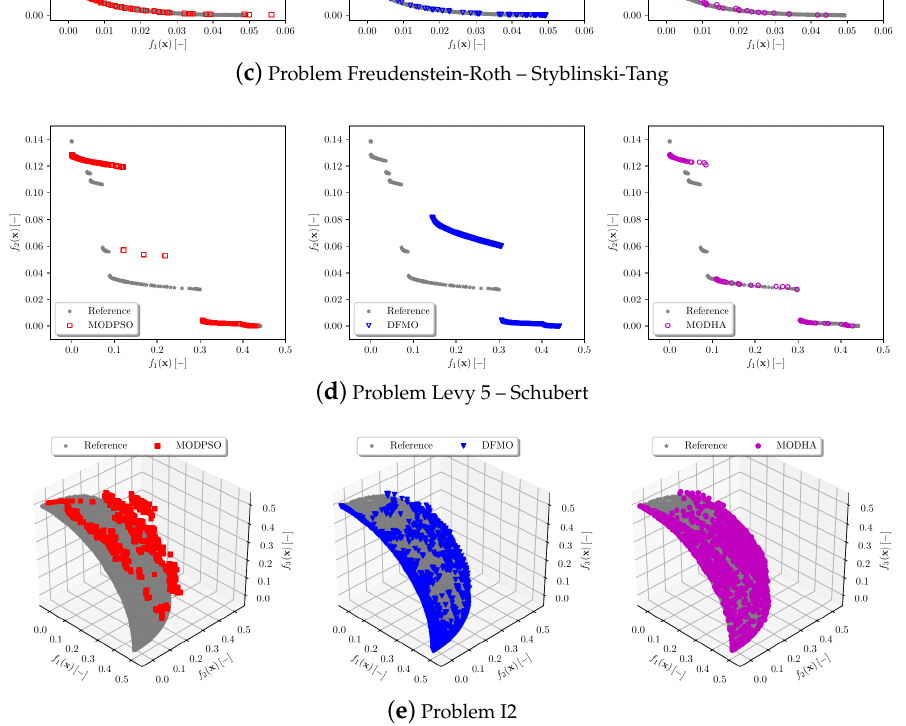
Figure 9. Analytical test problems: example comparison of the (normalized) non-dominated solution sets obtained by MODPSO, DFMO, and MODHA with the most promising parameters